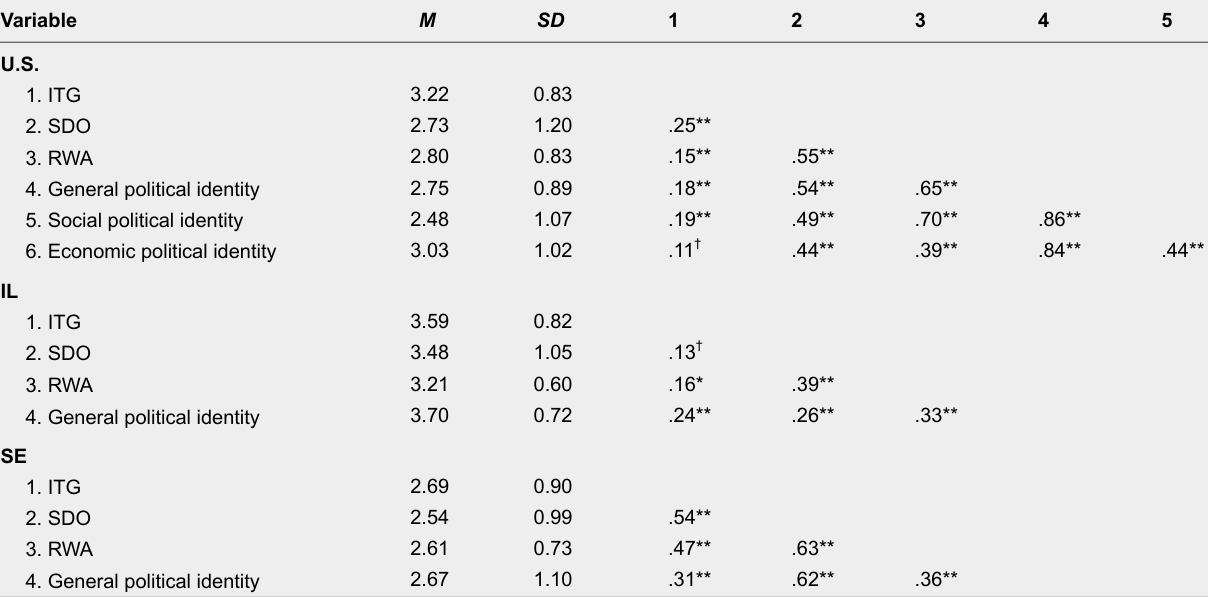
Means, Standard Deviations and Intercorrelations for All Study 2 Variables